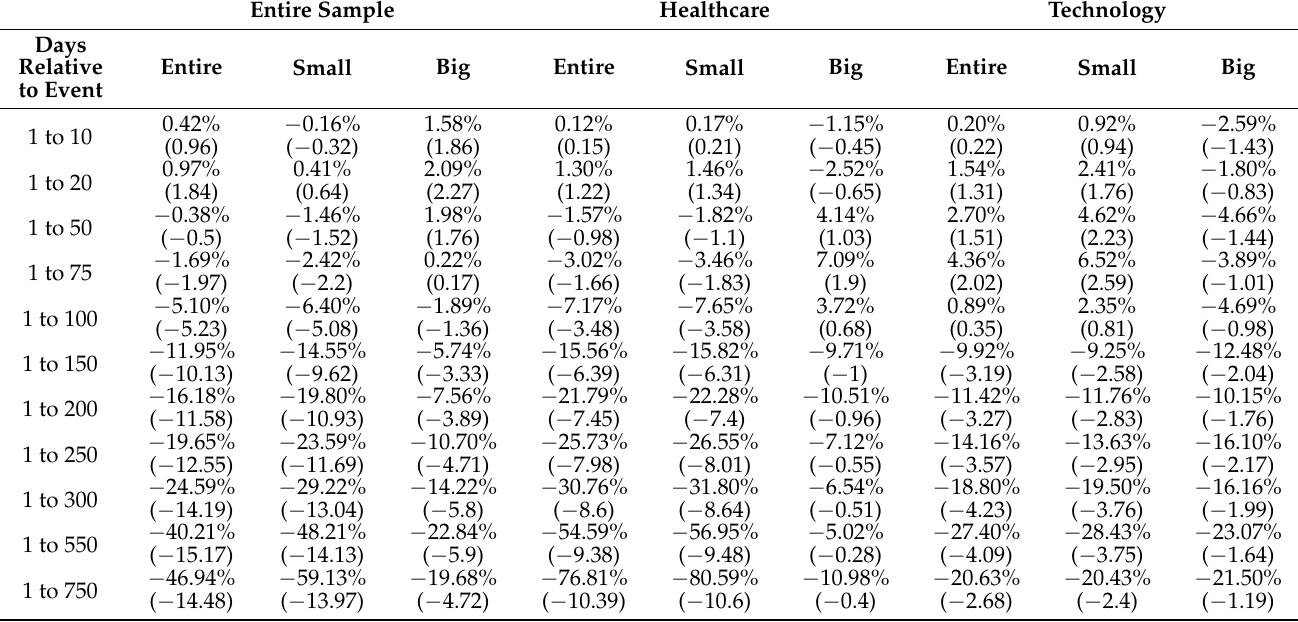
Table 7. Sectors and their Subsample CAARs divided by Asset Value Pre